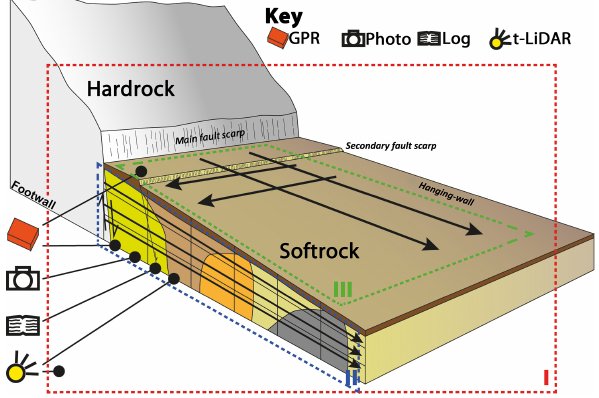
Figure 2. A simplified model of investigated parts on footwall, scarp, hanging wall, and trench at both exposures of this study; visualisation shows the conditions at the Sfaka road cut. Dashed lines show the different work spaces: (I) red, overall workspace for a long–mid-range t-LiDAR scan to retrieve the geometric relation of investigated components; (II) blue, area of operations (log, photo, t- LiDAR, GPR) on the trench wall; (III) green, workspace for GPR measurements (black arrows) on top of the